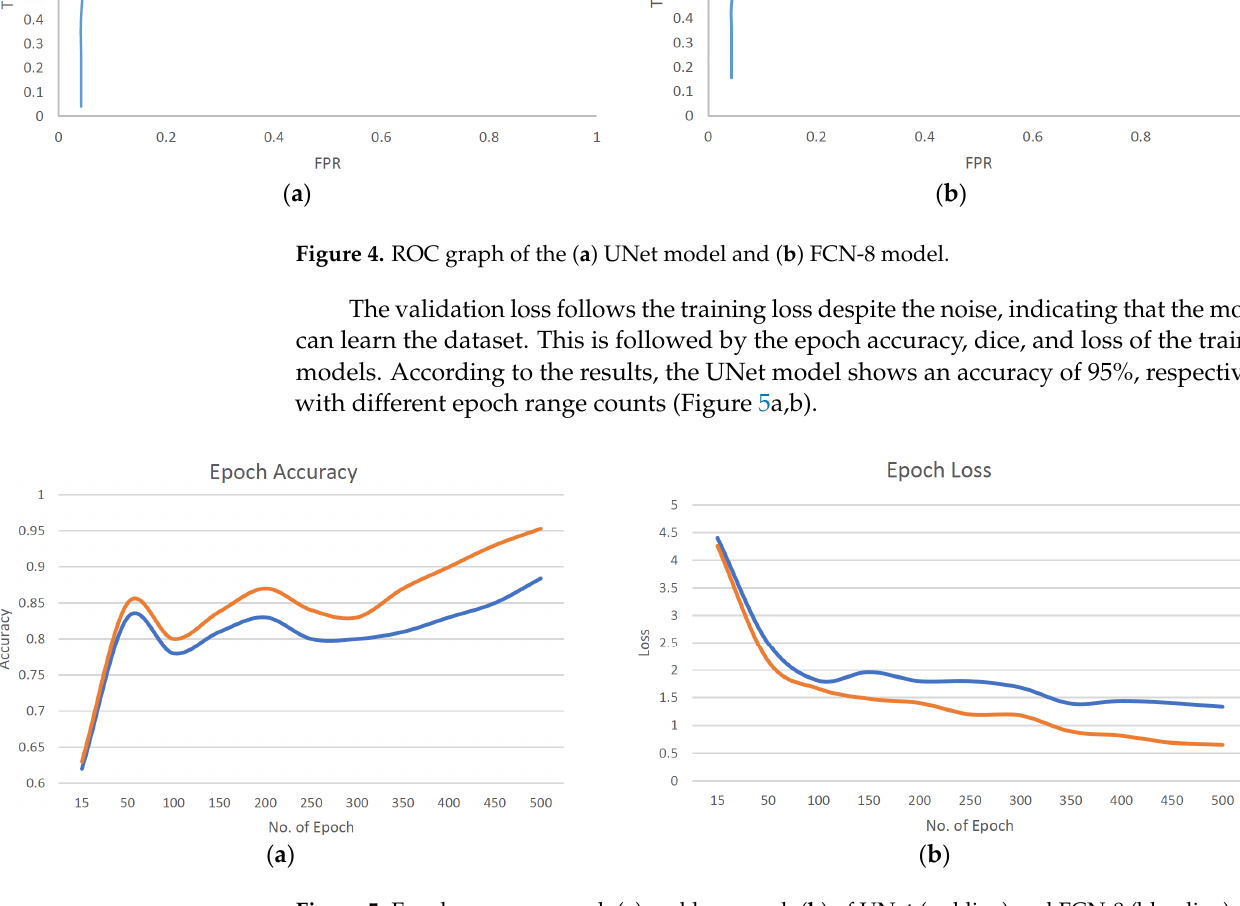
ers with different epoch range counts.